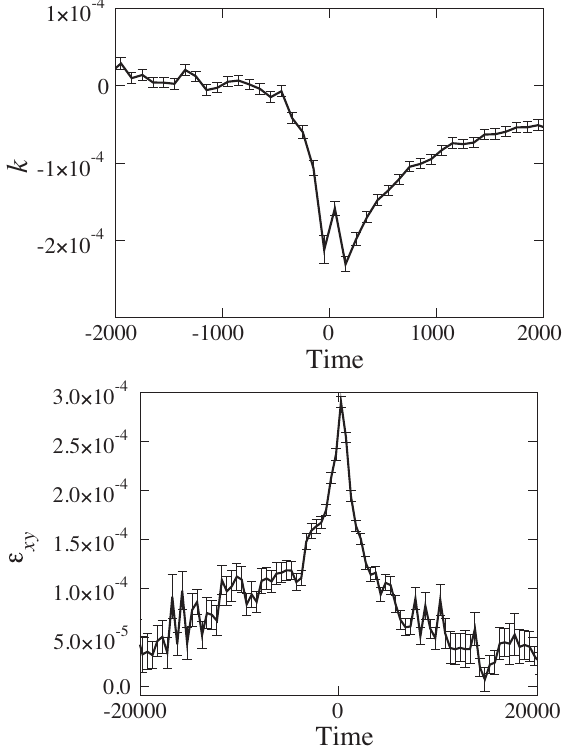
rises above the thresh- min